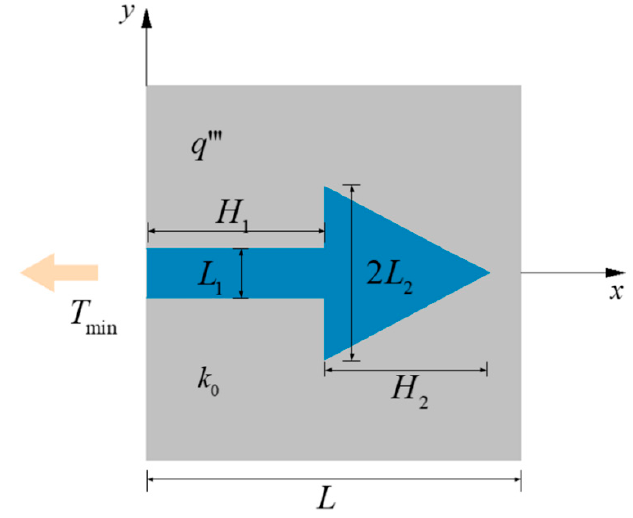
Figure 1. Square HGB with “Arrow-shaped” HTCC model [24].